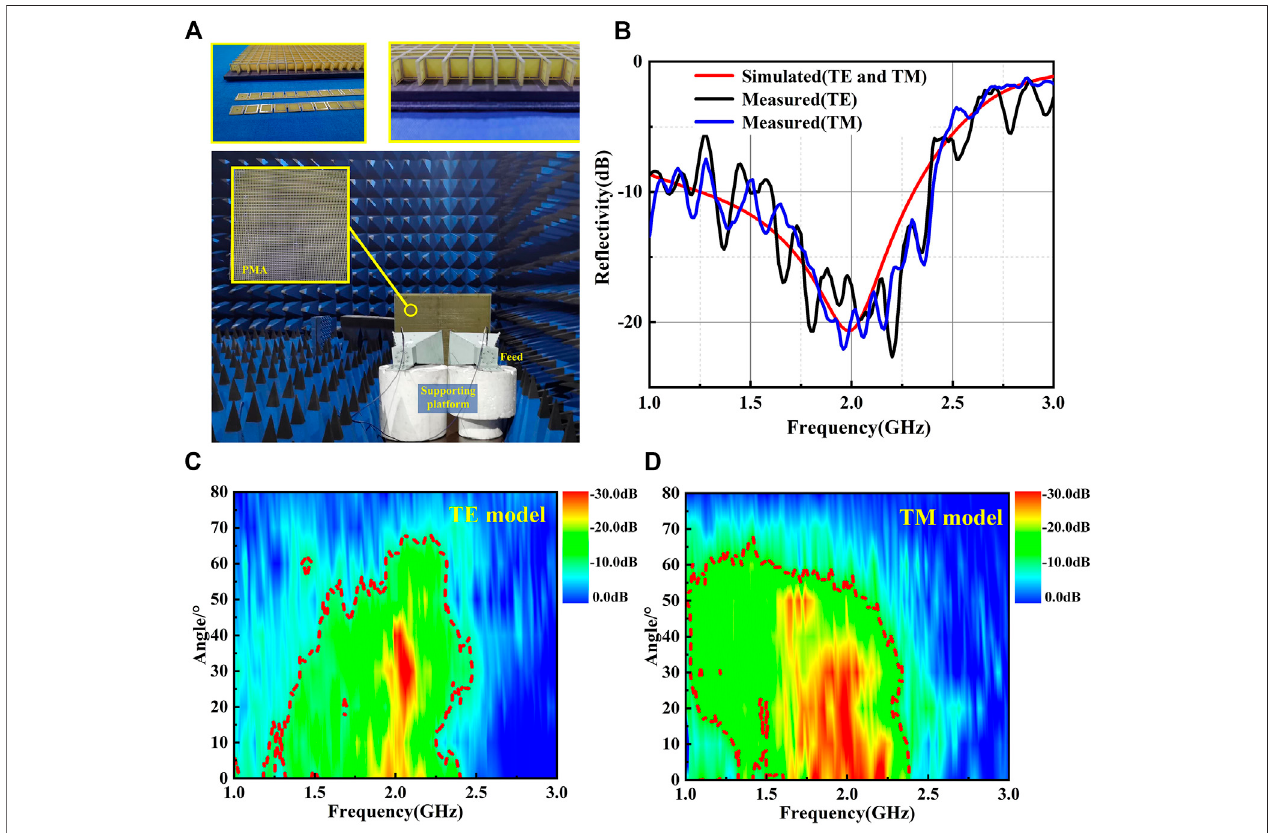
FIGURE 5 | (A) The fabricated prototype of the MA and the measured environment of oblique incidence. (B) Comparison between simulated and measured re fl ectivity spectra under normal incidence. Measured re fl ectivity spectrum varied with different incident angles under (C) TE and (D) TM polarized waves.